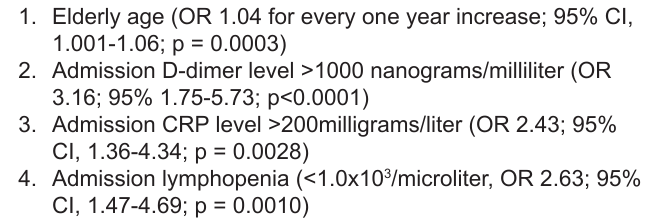
Table 3. Key demographic and laboratory factors associated with mortality from COVID-19.